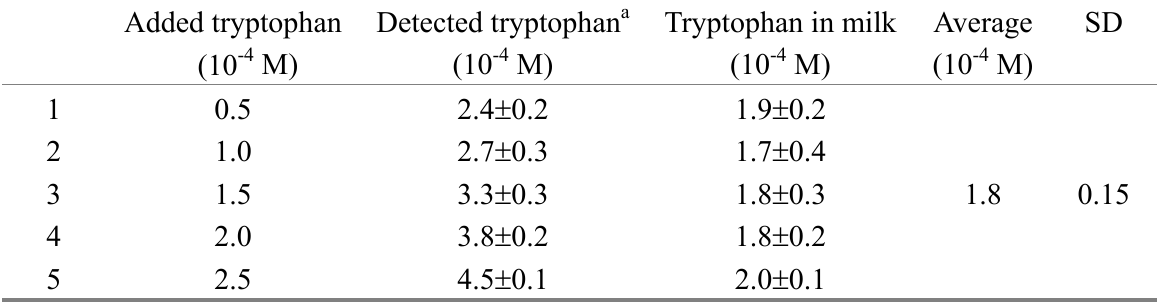
Table 1. Determination of tryptophan in milk by standard